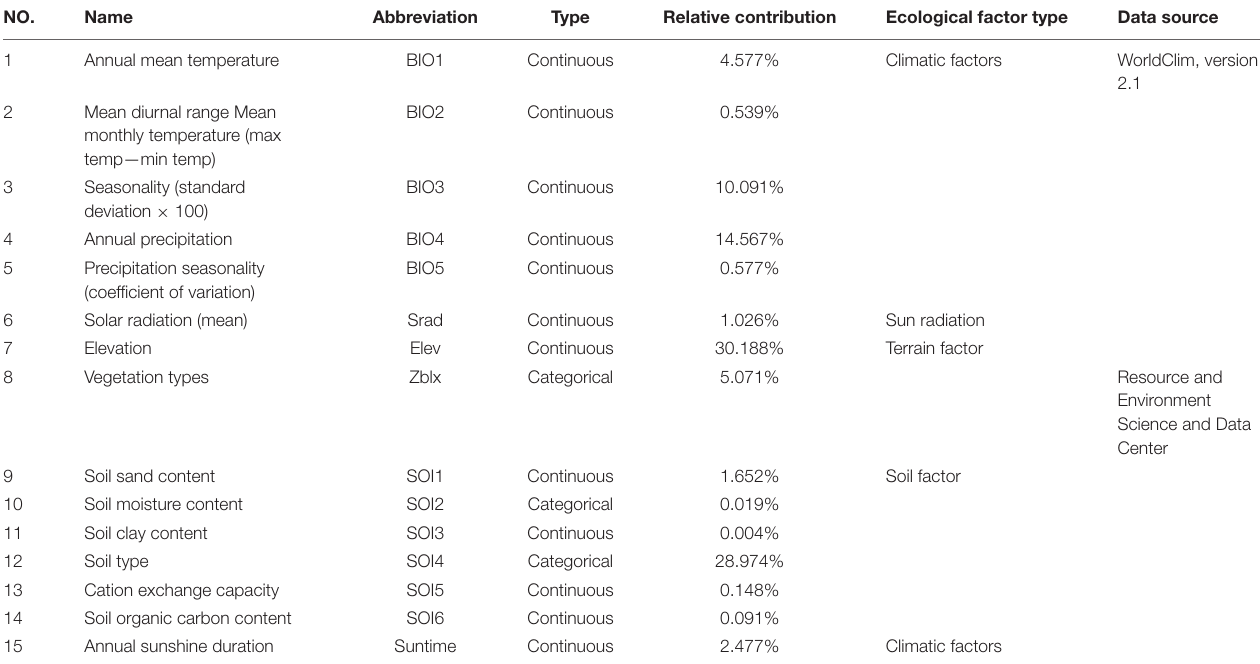
FIGURE 2 | Geographical location of Gentiana dahurica sample points and the terrain in Inner Mongolia. TABLE 1 | Details of the 15 ecological factors used to predict G. dahurica